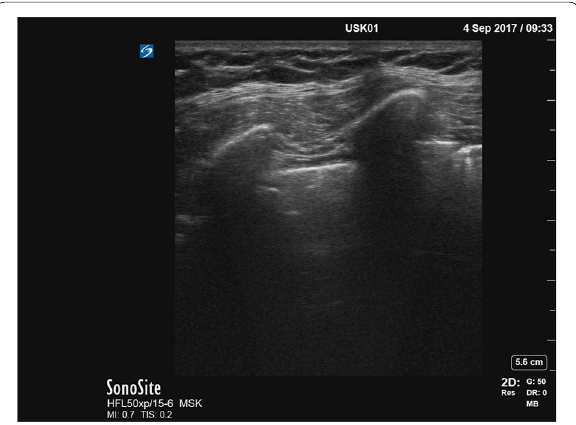
Fig. 1 A typical uncropped image of the pleural interface, acquired with the phased-array transducer. On the right, the cropped version is displayed as is was played back to the